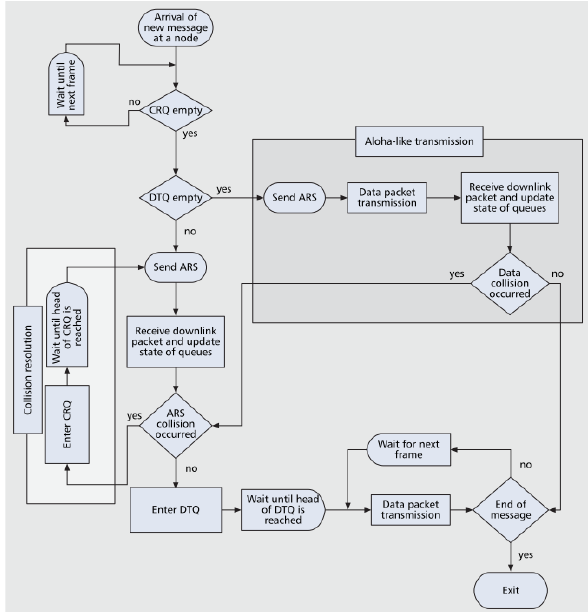
Figure 1. Distributed Queuing algorithm flow